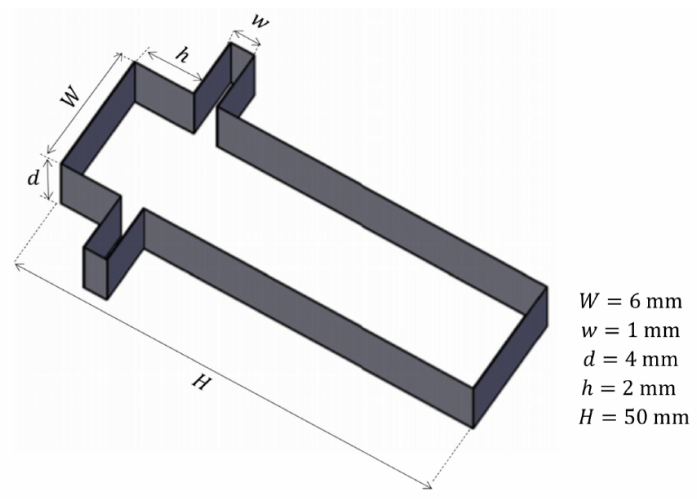
Figure 1. Sketch of T-jet